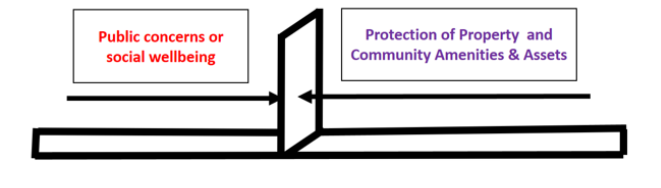
Fig. 9. Newtonian mechanics applied in BSP (developed by the